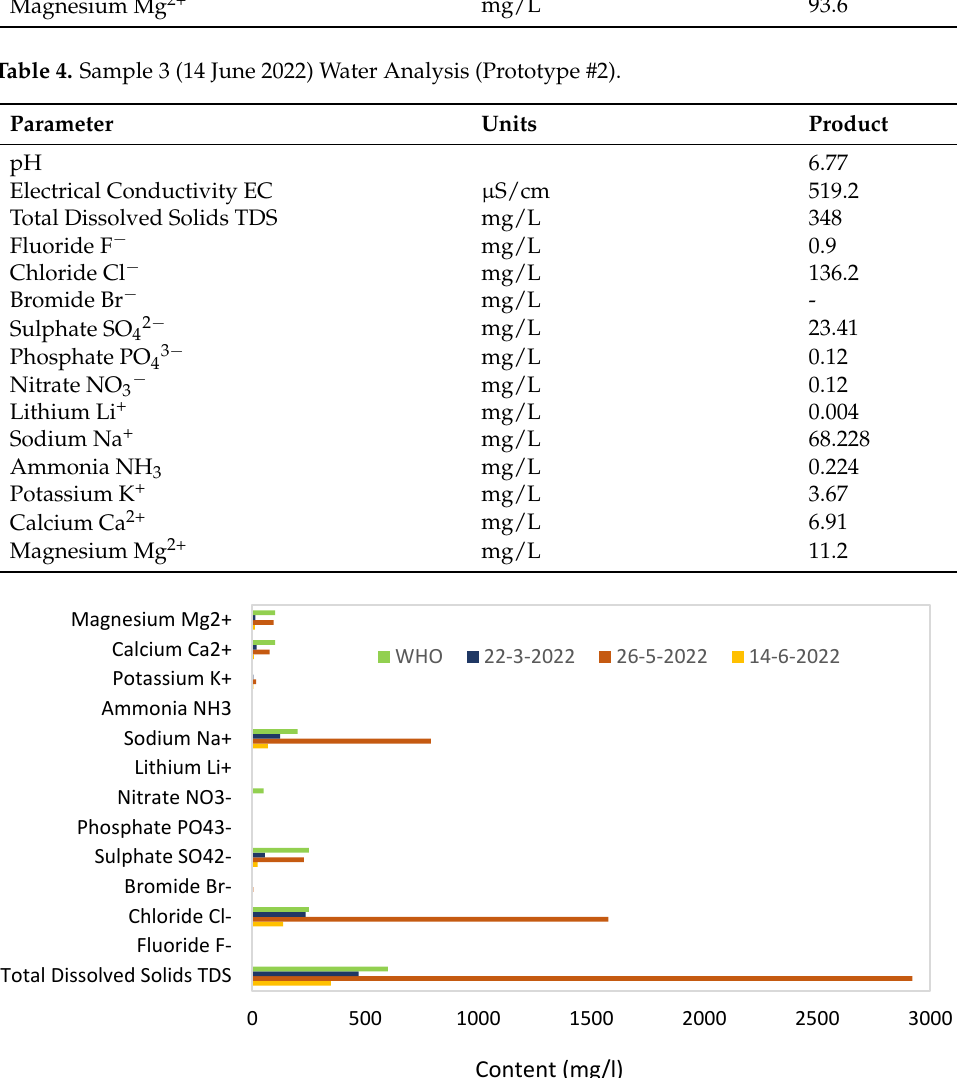
Figure 15. Water analysis samples of the fresh water produced in comparison with the WHO stand ‐